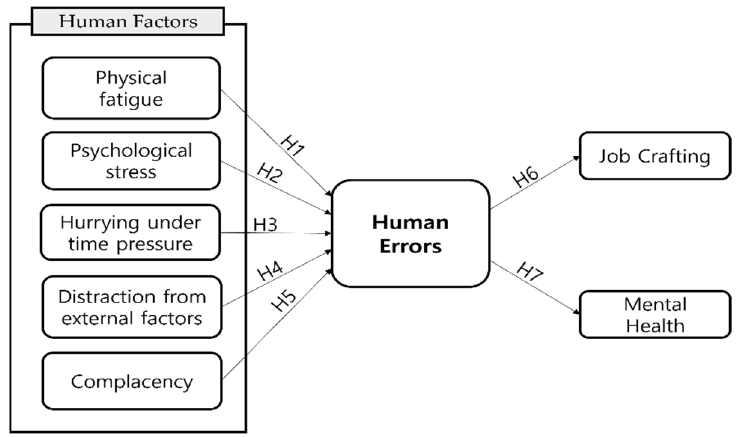
Figure 1. Research